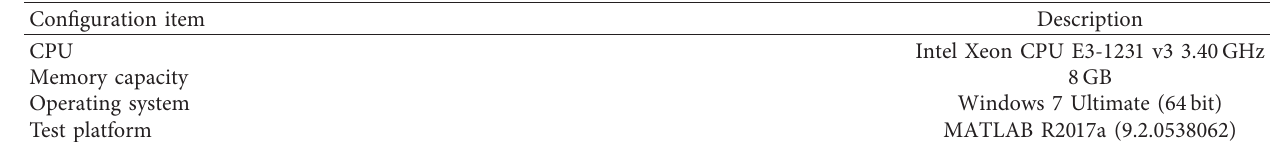
Table 2: Software and hardware configurations used in simulation tests.